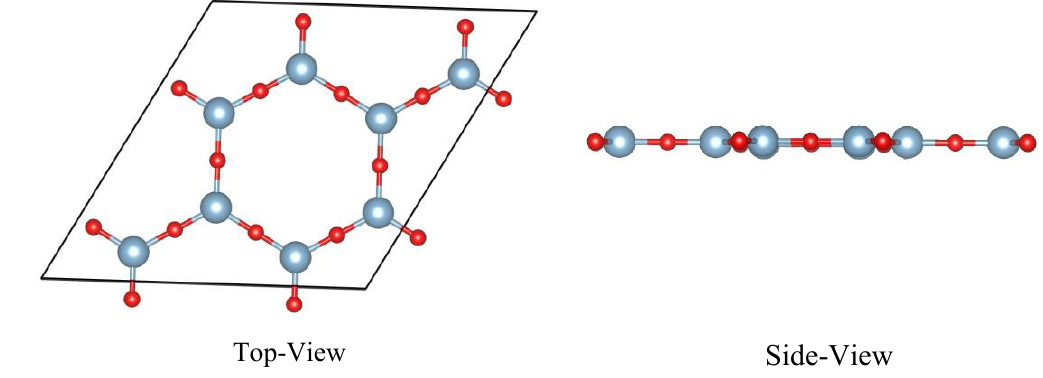
O monolayer 2 3